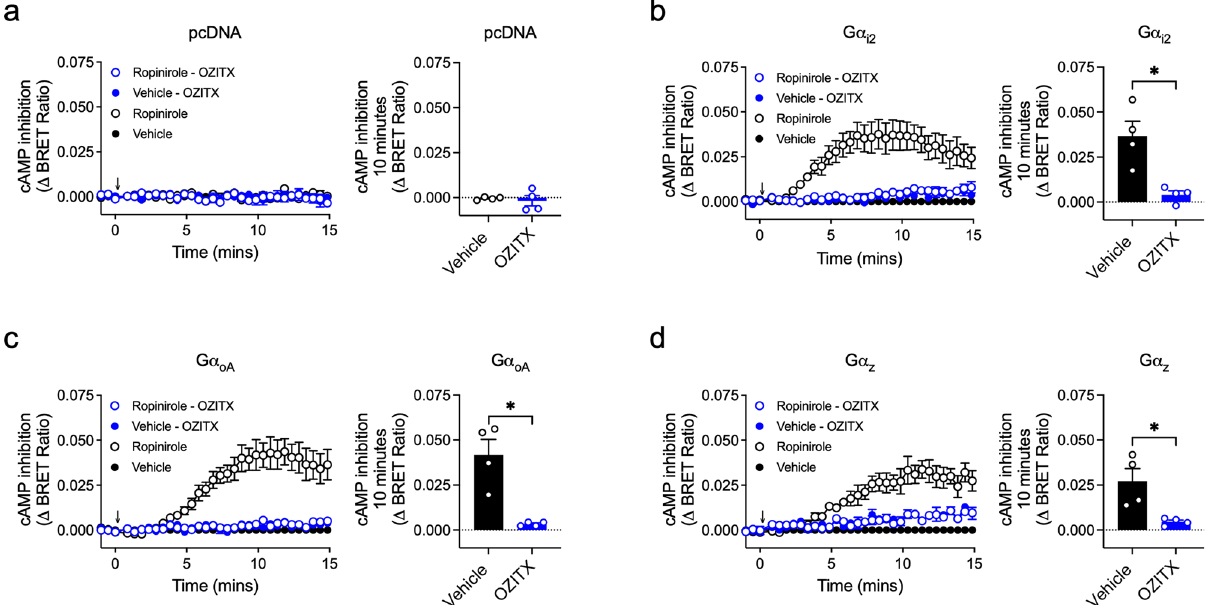
Fig. 4 The effect of OZITX on G α i2-, G α oA- and G α z-mediated inhibition of cAMP production. Inhibition of forskolin-stimulated cAMP production was detected in live cells using CAMYEL; a conformational BRET sensor based on EPAC. HEK 293 Δ G α i/o CRISPR cells were transfected with DNA encoding the D 2 R, CAMYEL and either ( a ) pcDNA3.1 + control, ( b ) G α i2 , ( c ) G α oA or ( d ) G α z . Transfected cells were then incubated with either vehicle (black) or OZITX (blue) for 24 h. Cells were then pre-stimulated with 10 µ M forskolin for 10 min before stimulation with either vehicle control ( fi lled circles) or 1 μ M ropinirole (open circles). Data are baseline-corrected to the cells not treated with OZITX or ropinirole and is shown as the mean ± SEM from four separate experiments. Measurements of cAMP inhibition between vehicle and OZITX-treated conditions were compared using an unpaired Student ’ s t test * represents statistical signi fi cance P < 0.05 (pcDNA – P = 0.700, G α i2 − P = 0.008, G α oA – P = 0.004 , G α z –